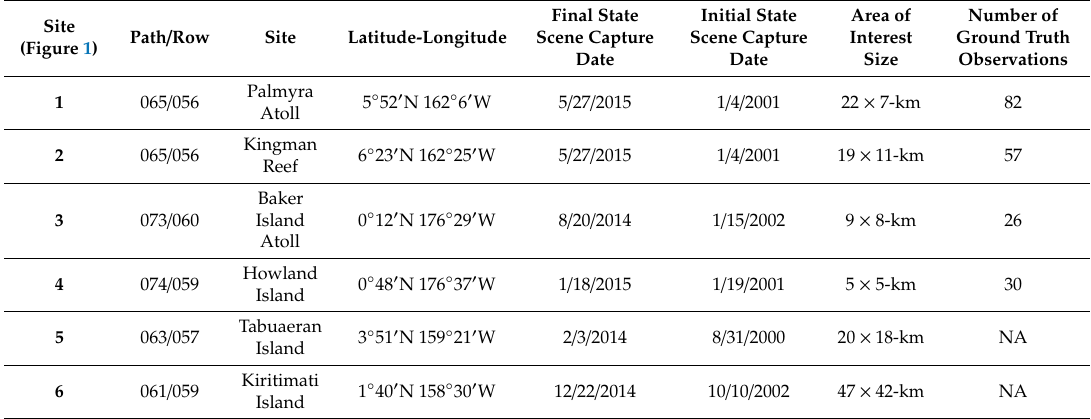
Table 2. Satellite Data